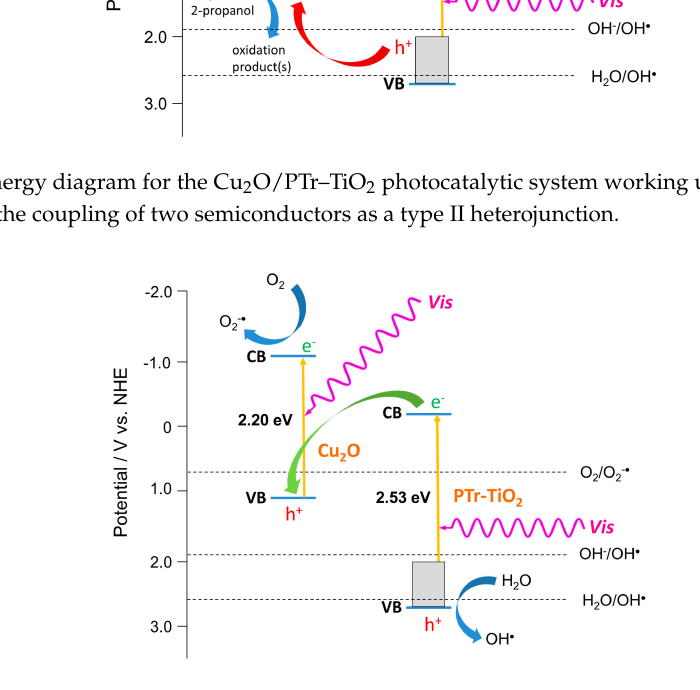
Figure 9. Energy diagram for Cu 2 O/PTr–TiO 2 photocatalytic system working under visible light, illustrating the coupling of two semiconductors as a Z-scheme